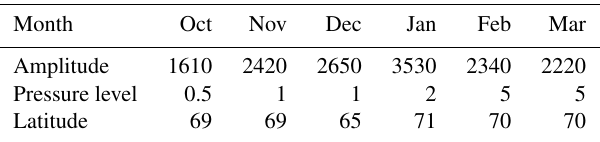
Table 2. Stationary planetary wave amplitude (m) and location of its peak (pressure level (hPa) and latitude ( ◦ N)) in the stratosphere for October to March. Month Oct Nov Dec Jan Feb Mar Amplitude 1610 2420 2650 3530 2340 2220 Pressure